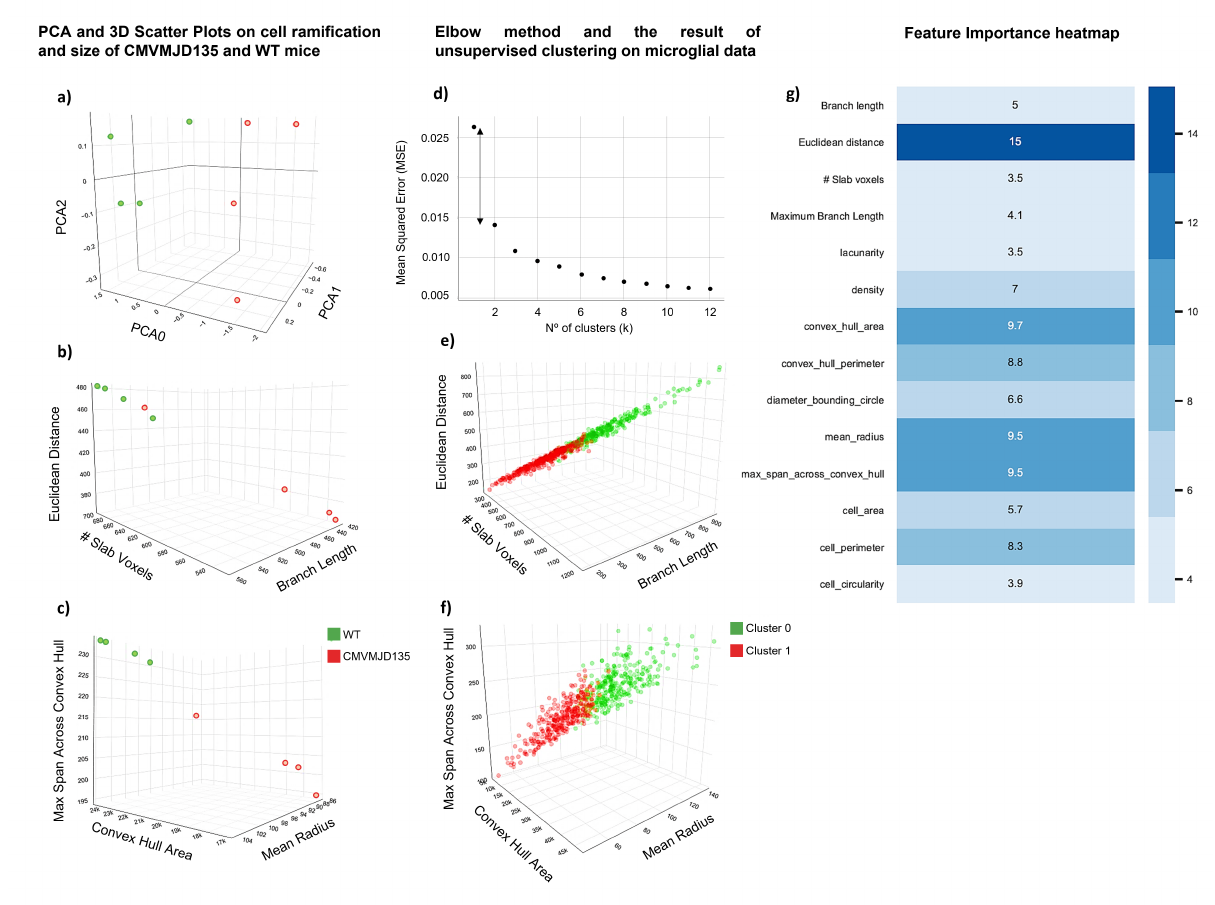
Figure 6. A clear separation of microglia in the CSC of CMVMJD135 and WT mice regarding features associated with cell ramification and cell size. ( a ) A 3D scatter plot showing the distribution of CMVMJD135 mice (in red) and WT animals (in green) on a principal components plane. ( b ) A 3D scatter plot showing a clear separation between CMVMJD135 and WT mice regarding the number of slab voxels, branch length, and Euclidean distance; and ( c ) a 3D scatter plot showing a clear separation between CMVMJD135 and WT mice regarding their convex hull area, mean radius, and maximum span across the convex hull. ( d ) Graphical result of the elbow method applied on the dataset comprised of 310 cells from WT mice and 389 from CMVMJD135 ones. ( e , f ) Data points of a total of 310 microglial cells from WT mice and 389 microglial cells from CMVMJD135 mice were plotted as a function of the significant features, belonging to one of two clusters: cluster 0, in green, or cluster 1, in red. ( e ) A 3D scatter plot showing the relationship between the number of slab voxels, branch length, and Euclidean distance; and ( f ) a 3D scatter plot showing the relationship between the convex hull area, mean radius, and maximum span across the convex hull of all microglia. ( g ) Feature importance heatmap for each parameter used to classify microglia from CMVMJD135 and WT mice. The higher the color tone, the higher the importance of the